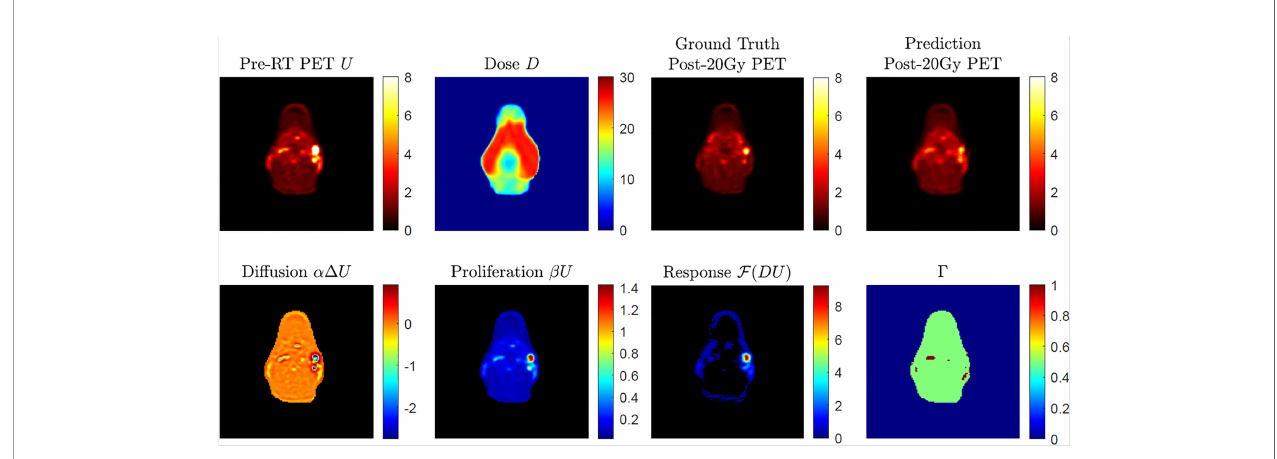
FIGURE 2 | An example of post-radiotherapy 18 FDG-PET image outcome with given pre-radiation 18 FDG-PET image and dose distribution map D, with a breakdown of predicted biological effects (diffusion, proliferation, and dose response in absolute value) in Eq. (2). The 2D Gamma ( G ) test result was obtained through acceptance criteria of 5%/10